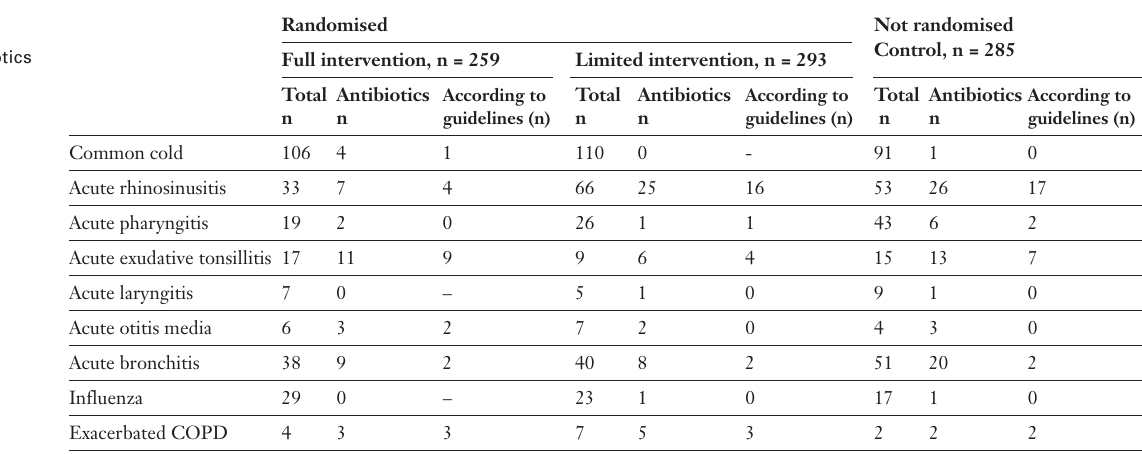
Prescribed antibiotics per